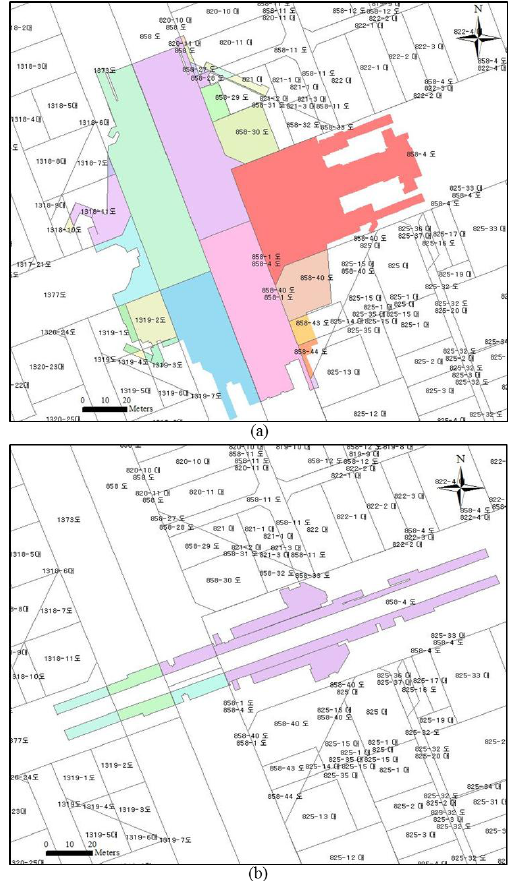
Figure 11. 2D surface parcel with footprints of 3D underground cadastral map in Gangnam subway station: ( a ) 1st underground floor: Gangnam underground shopping mall; and ( b ) 2nd underground floor: subway station platform.